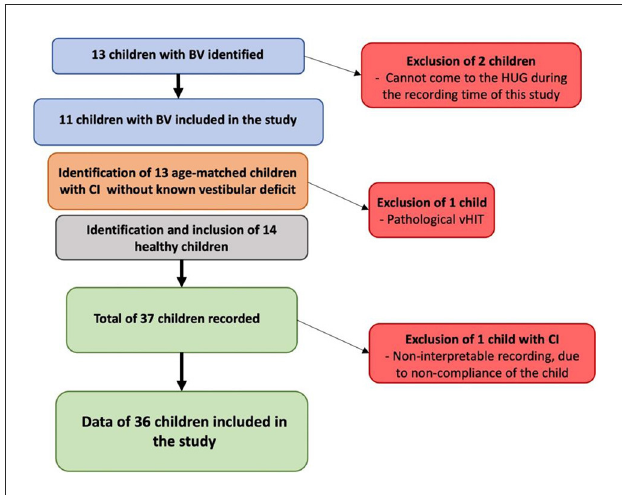
FIGURE1 Summary of the recruitment process of the study population and the number of children